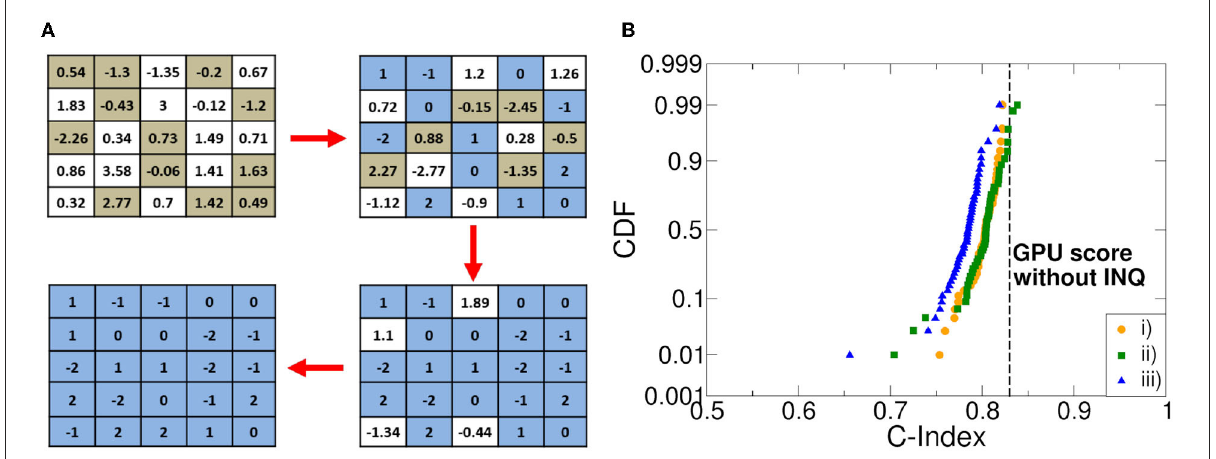
FIGURE5 (A) An example of the application of the incremental network quantization (INQ). algorithm. (B) cumulative distribution function (CDF) of the C-index retrieved in Monte Carlo simulations with different weight picking strategies compared with the C-index obtained by a graphic processing unit (GPU) without quantization in training and working with full floating-point